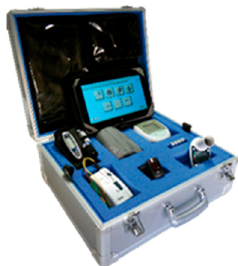
Figure 1. Nurse kit (KIT Lifechart Home_Meditel s.r.l) that consisted of a briefcase containing a tablet, a precision balance, an oxymeter, an electronic sphygmomanometer, and a 12-leads electrocardiograph (HeartView P-12/8).